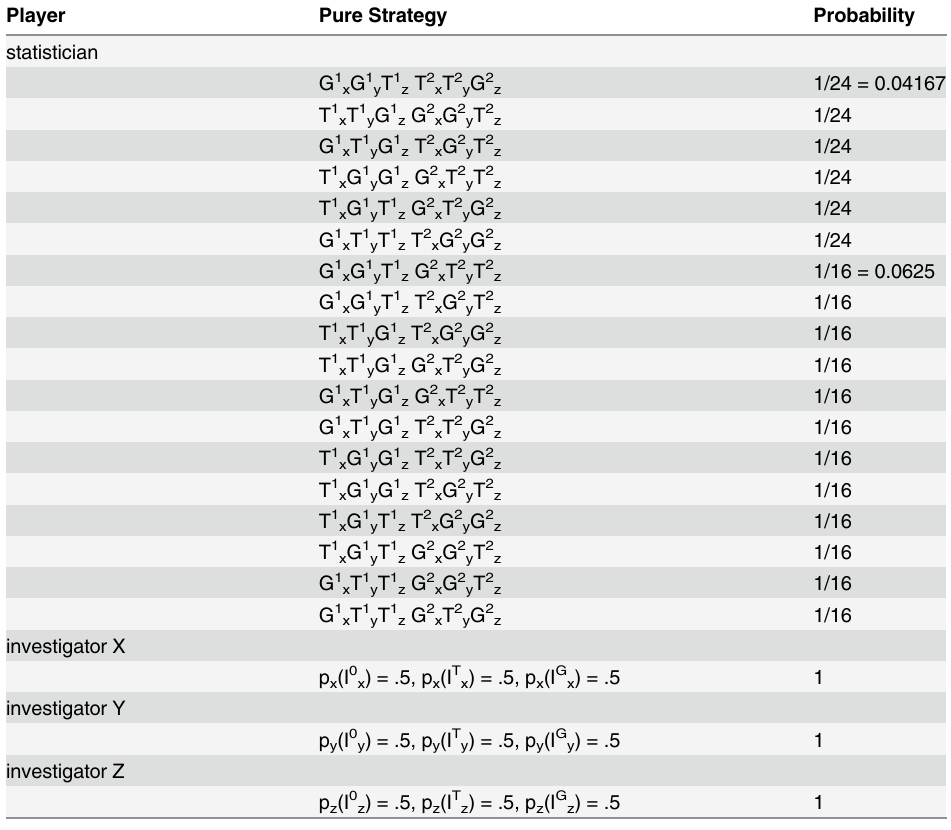
Table 1. A Run-Reversal Equilibrium with Three Clinical Sites. Player Pure Strategy